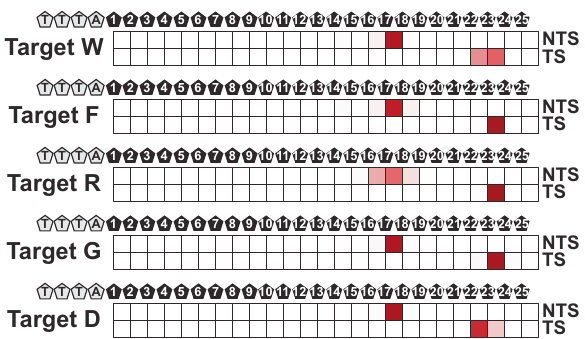
YmeCas12a requires elevated temperature for optimal trans nuclease activity . We were surprised that a minimal fl uorescent signal was generated with Yme in reporter DNA assays after 30 min at 37 °C since it is capable of ef fi cient target DNA cleavage at that temperature (Figs. 2 and 6b). Modulating reaction conditions, we observed an increase of fl